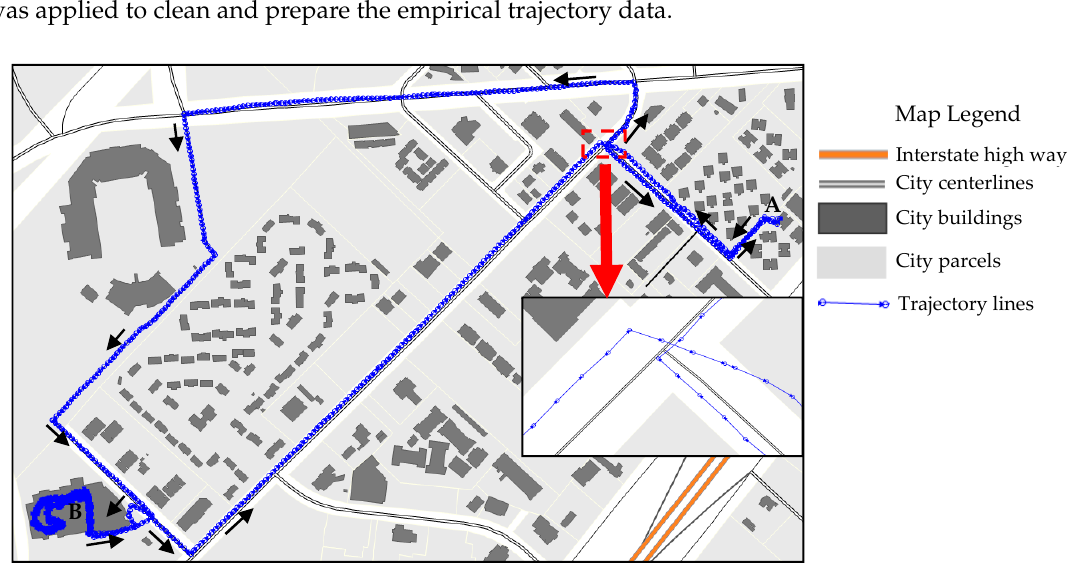
Figure 5. A GPS trajectory of 1141 points collected for a walking trip. It was a round trip following the arrows, starting from point A, arriving at point B, and back to A by a different route.